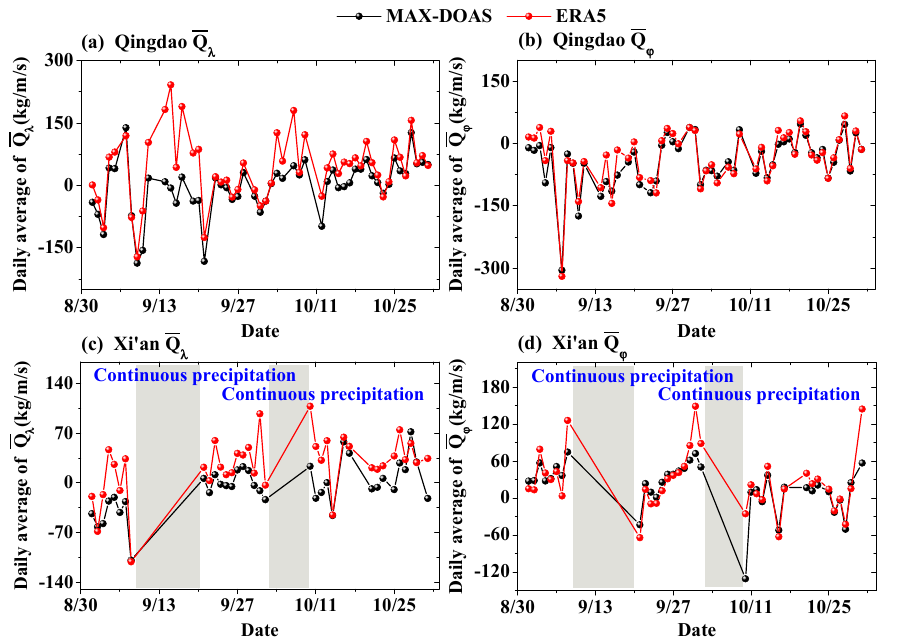
Figure 6. Comparison of MAX-DOAS measurements and ERA5 reanalysis datasets for water vapor flux (WVF): ( a ) the zonal vertically integrated WVFs in Qingdao; ( b ) the meridional vertically integrated WVFs in Qingdao; ( c ) the zonal vertically integrated WVFs in Xi’an; ( d ) the meridional vertically integrated WVFs in Xi’an.